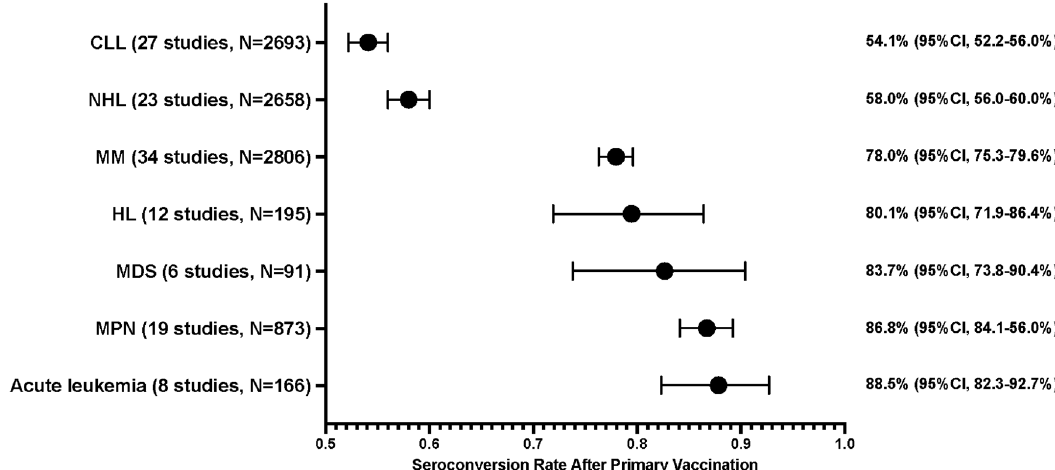
Fig. 2 Pooled seroconversion rates following complete primary SARS-CoV-2 vaccination in each disease subtype of hematologic malignancies. CLL chronic lymphocytic leukemia, HL Hodgkin lymphoma, Leukemia acute leukemia, MDS myelodysplastic syndrome, MM multiple myeloma, MPN myeloproliferative neoplasms, NHL non-Hodgkin